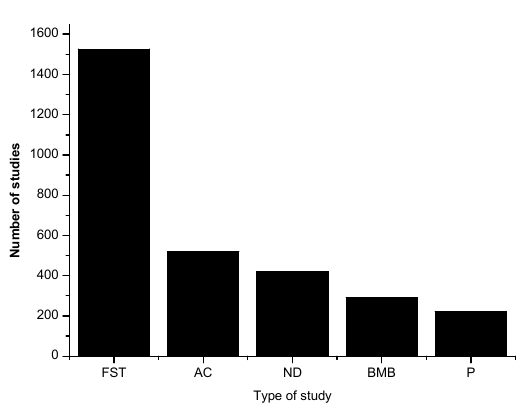
Figure A1. Number of studies in 2016 by discipline (FST, Food Science and Technology; AC, Applied Chemistry; ND, Nutrition and Dietetics; BMB, Biochemistry and Molecular Biology; P, Pharmacology).